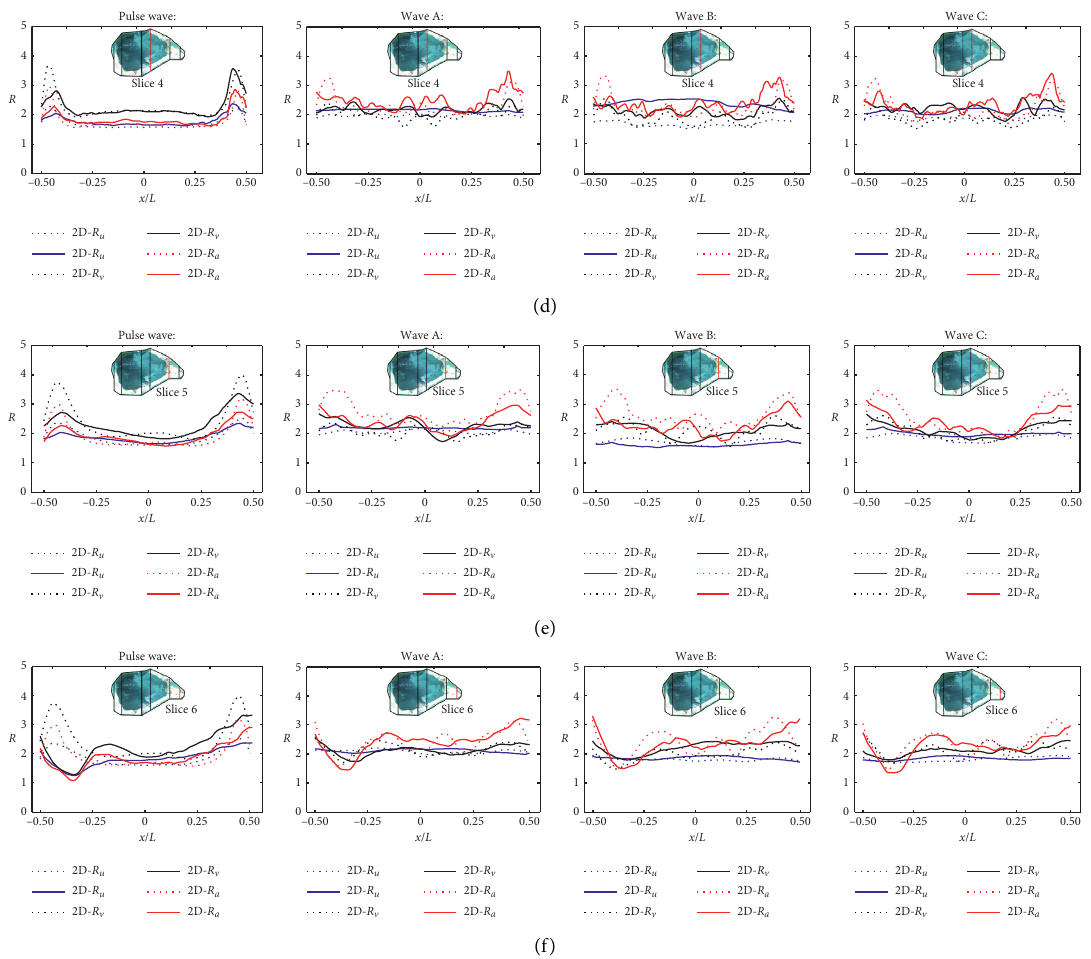
Figure 9: Distributions of the amplification ratio of the peak displacement, velocity, and acceleration on the reef flat. Table 2: Average amplification ratios of peak acceleration on the reef flat calculated by the 2D and 3D models and their relative deviations. Pulse wave Wave A Wave B Wave